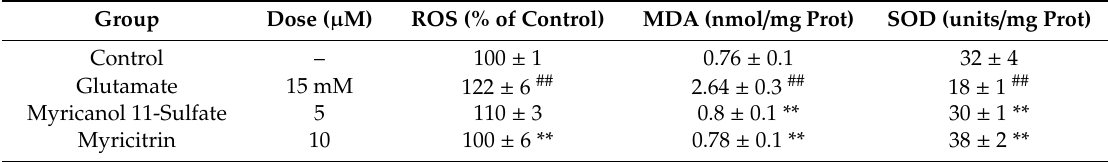
Table 2. E ff ects of Myricetrin and myricanol 11-sulfate on intracellular ROS, Malondialdehyde (MDA) and superoxide dismutase (SOD) levels in glutamate-induced damage to PC12 cells (x ± s, n = 6). Group Dose ( µ M) ROS (% of Control) MDA (nmol / mg Prot) SOD (units / mg Prot) Control – 100 ± 1 0.76 ± 0.1 32 ± 4 Glutamate 15 mM 122 ± 6 ## 2.64 ± 0.3 ## 18 ± 1 ## Myricanol 11-Sulfate 5 110 ± 3 0.8 ± 0.1 ** 30 ± 1 ** Myricitrin 10 100 ± 6 ** 0.78 ± 0.1 ** 38 ± 2